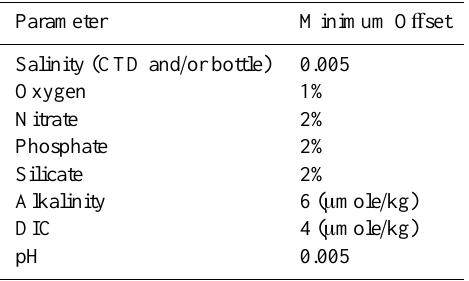
Table 1. Minimum o ff set values considered for adjustment. Not all cruise to cruise di ff erences that exceeded the minima were adjusted. In a very few cases (with very precise data) smaller adjustments were made. A table of the adjustments applied to the CARINA copied to CDIAC for permanent